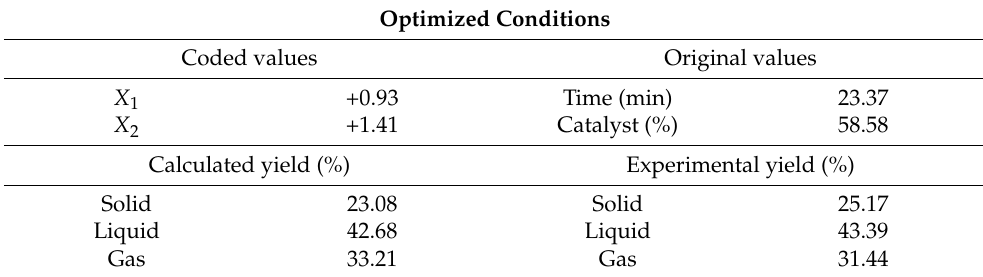
Table 5. Optimization results for product yields.